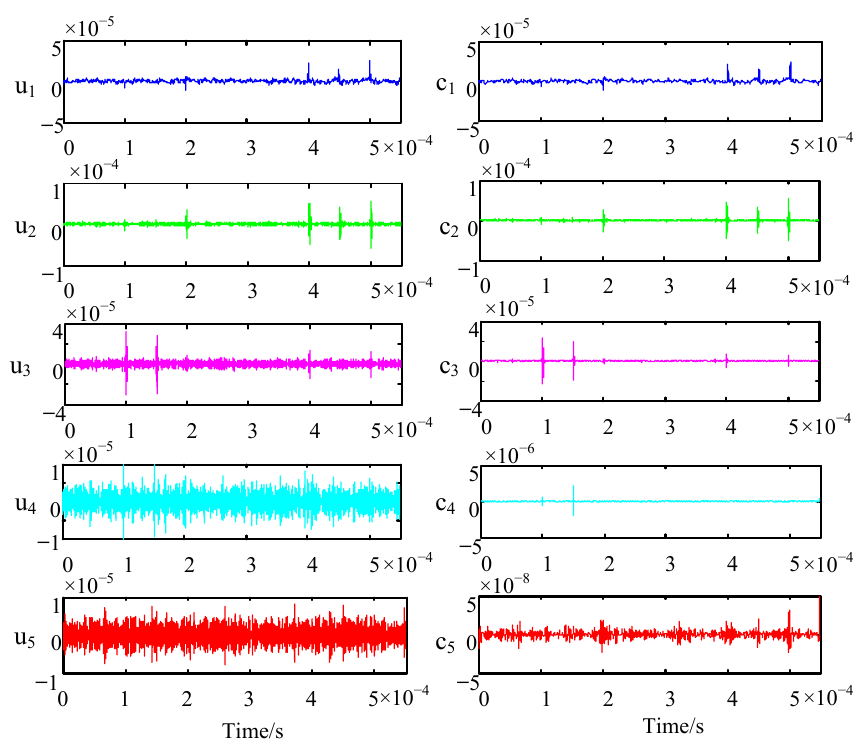
Figure 6. Intrinsic mode functions and wavelet threshold denoising